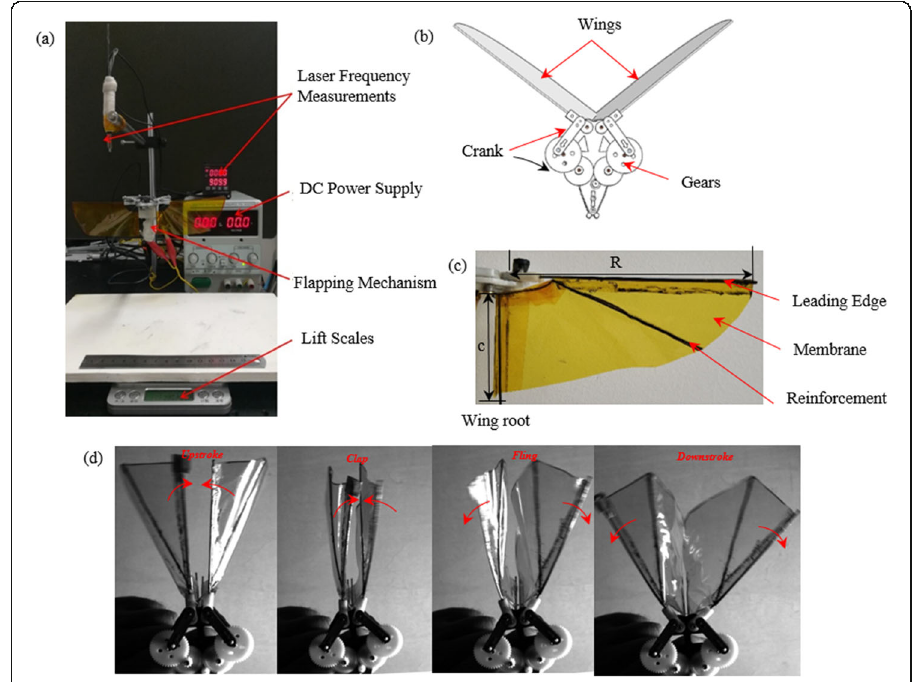
Fig. 2 Experimental apparatus and model ( a ) the fast lift measurement platform, ( b ) experimental test model, ( c ) Wing structure, ( d ) the flapping wings with clap-and-fling